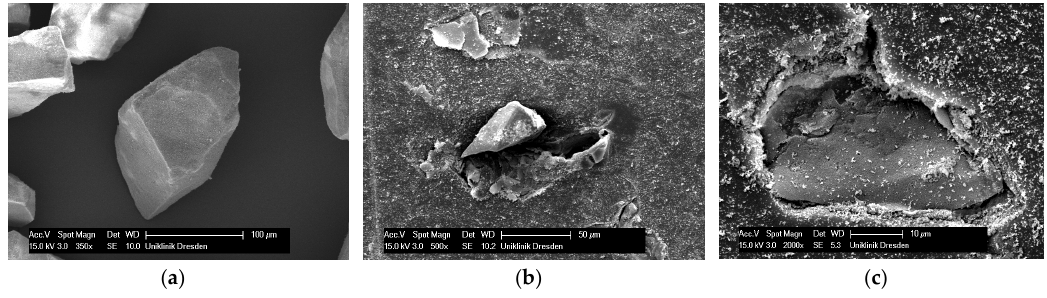
Figure 8. ( a ) Sandblasting agent (Rocatec Plus); ( b , c ) SEM images of impacted particles after sandblasting of PMMA resin surfaces.